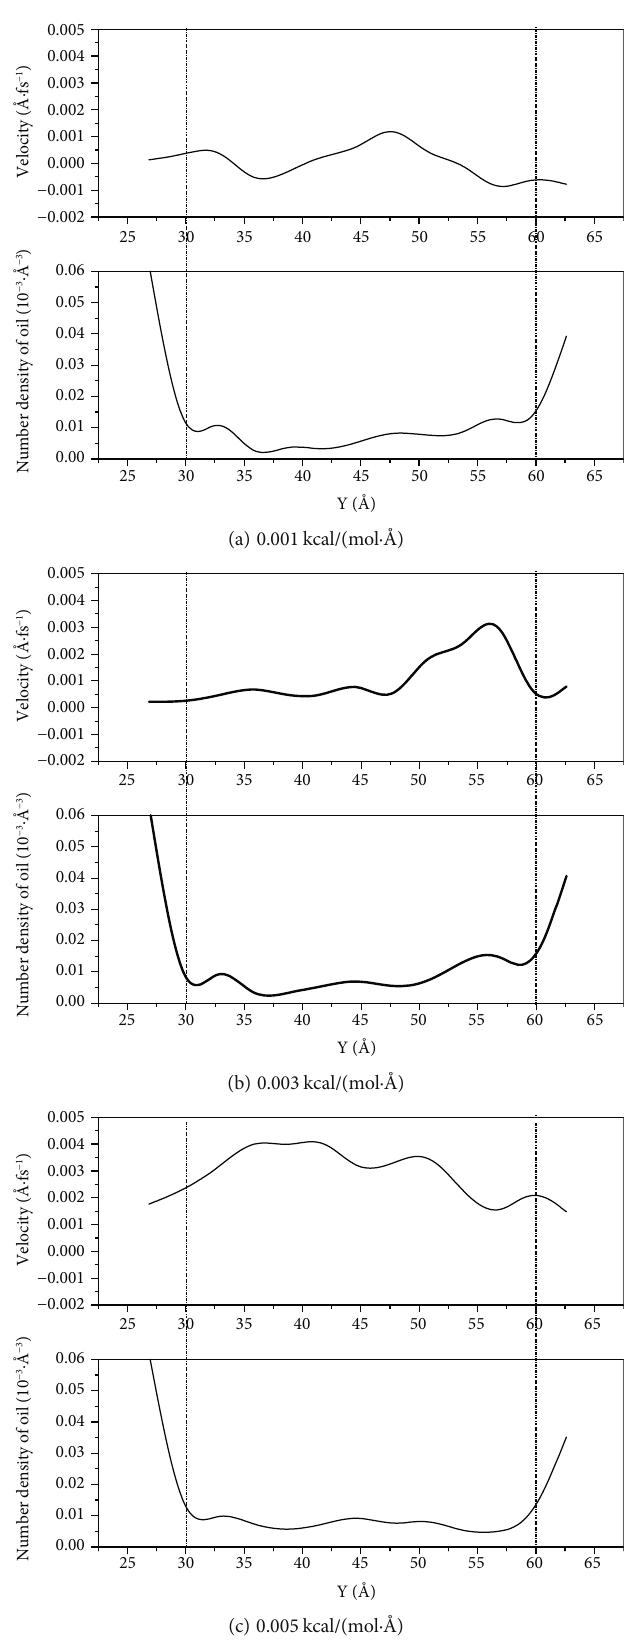
Figure 13: The fl ow velocity and density distribution of oil under di ff erent driving forces in the Y direction at